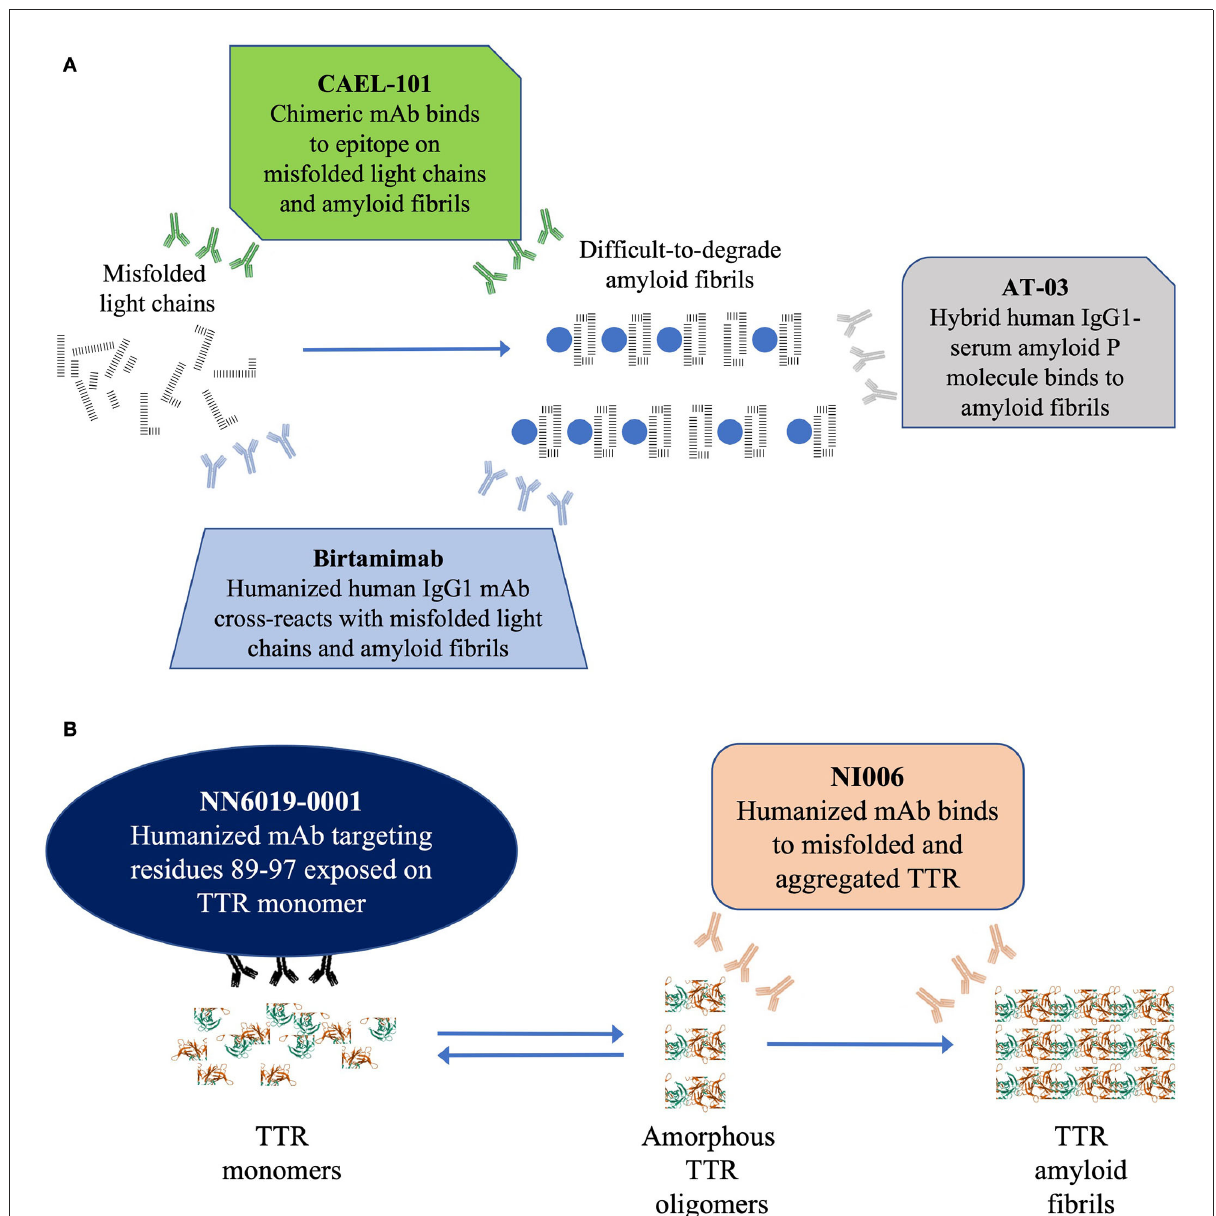
FIGURE2 (A) Schematic diagram depicting the 3 anti-fibril mAb therapies currently under investigation for AL amyloidosis and (B) Schematic diagram depicting the 2 anti-fibril mAb therapies currently under investigation for ATTR amyloidosis. In (A) this schematic figure shows the 3 mAbs currently under investigation for depletion of light-chain fibrils in AL amyloidosis. In (B) this schematic figure shows the 2 mAbs currently under investigation for depletion of TTR fibrils in ATTR amyloidosis. AL, light chain amyloidosis; IgG1, immunoglobulin G1; mAb, monoclonal